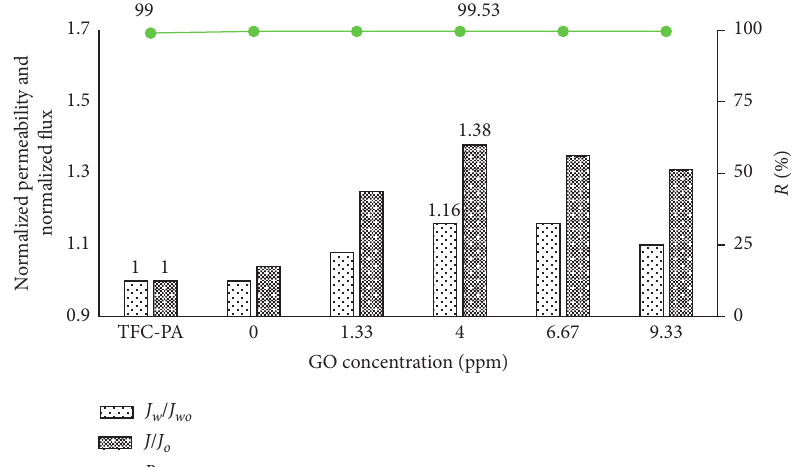
Figure 6: Normalized permeability and normalized flux of the uncoated and GO-TiO